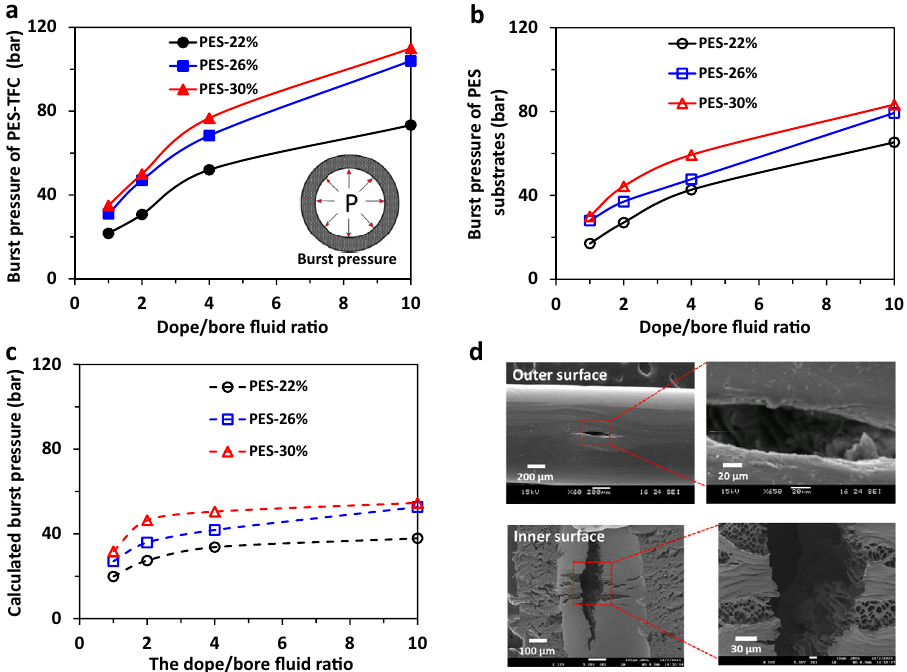
Fig. 6 Burst pressures of hollow fi ber membranes as a function of the dope to bore fl uid ratio and the morphology of the burst membrane. a The burst pressures of PES-TFC hollow fi ber membranes. b The burst pressures of PES hollow fi ber substrates. c Calculated burst pressure according to Barlow ’ s equation (Eq. 9) based on the dimension and maximum tensile stress of the substrates. d FESEM images of the representative burst PES-TFC hollow fi ber